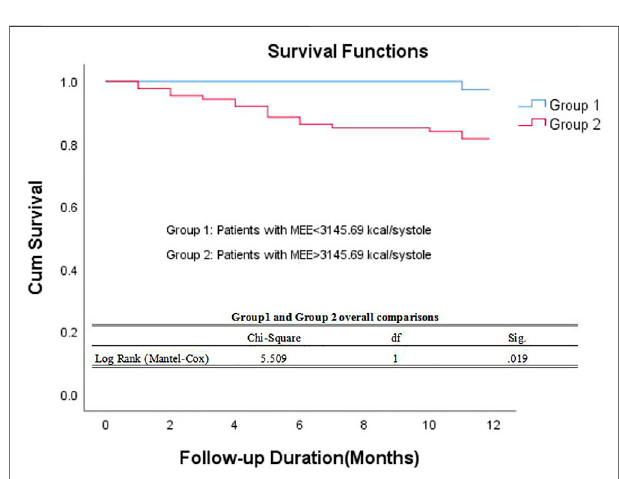
FIGURE 4 | Kaplan – Meier survival curve of participants. Demonstrating long-term all-cause mortality among patients groups speci fi ed based